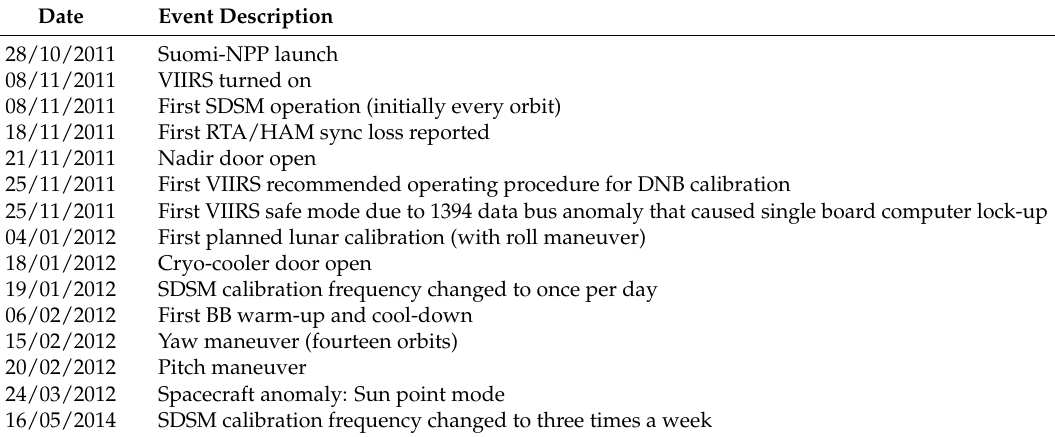
Table 2. Key events for S-NPP VIIRS on-orbit operation and calibration. SDSM, solar diffuser stability monitor; RTA, rotating telescope assembly; HAM, half-angle mirror; BB,